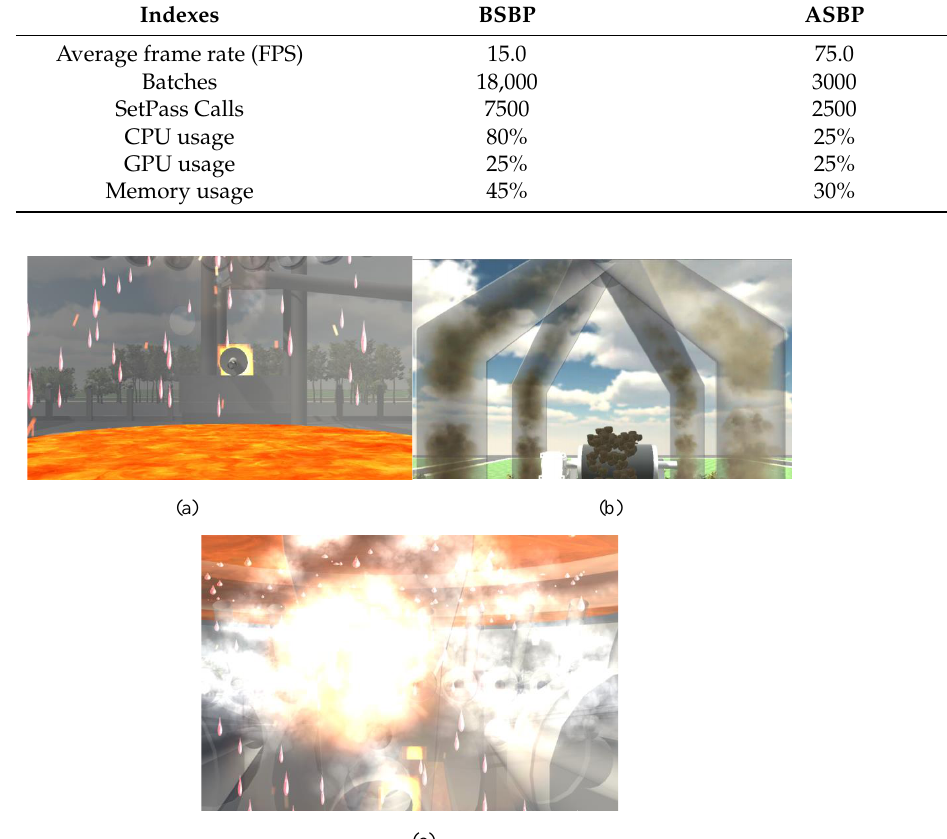
Figure 3. Particle animation renderings of the ironmaking blast furnace process. ( a ) The whole dripping effect of the molten iron which is the main reaction; ( b ) Airflow renderings; ( c ) Flame renderings of ironmaking production plant.